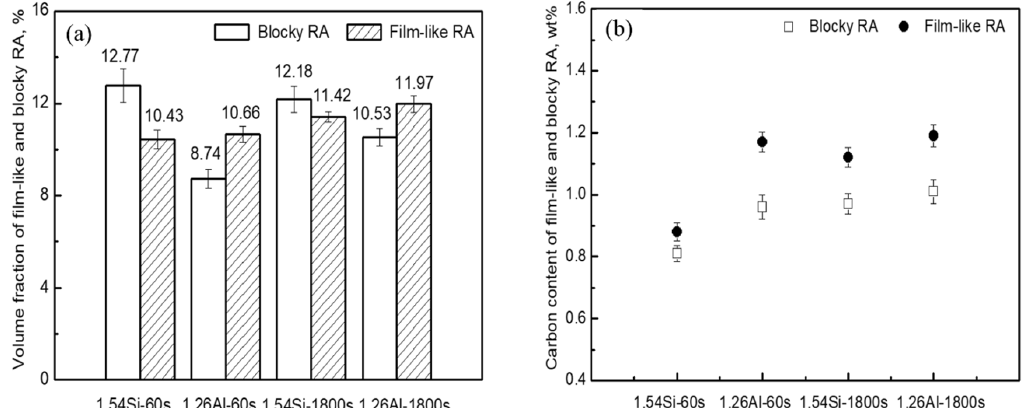
Figure 5. ( a ) the volume fraction of blocky and film-like RA; ( b ) the carbon content of blocky and film-like RA in different heat-treated specimens.